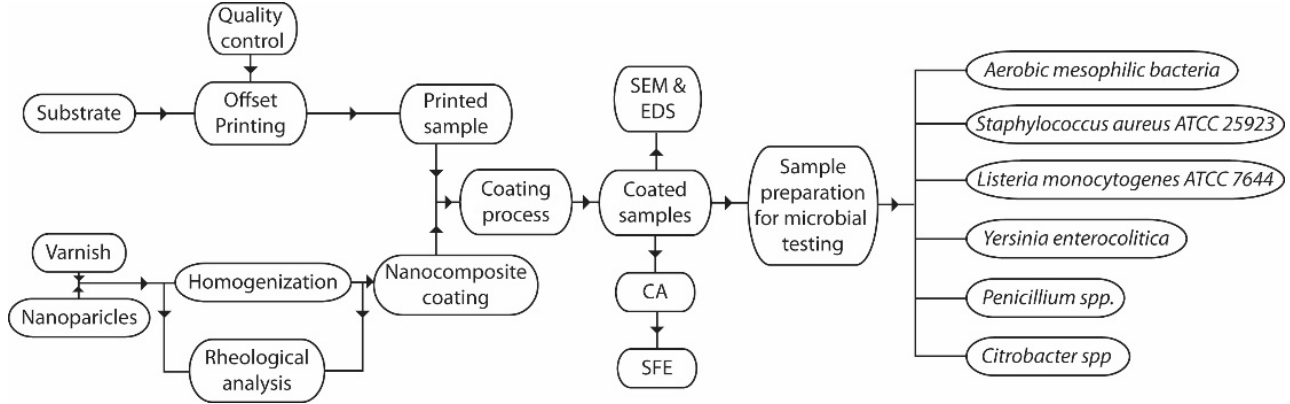
Figure 1. Experiment setup for this research .